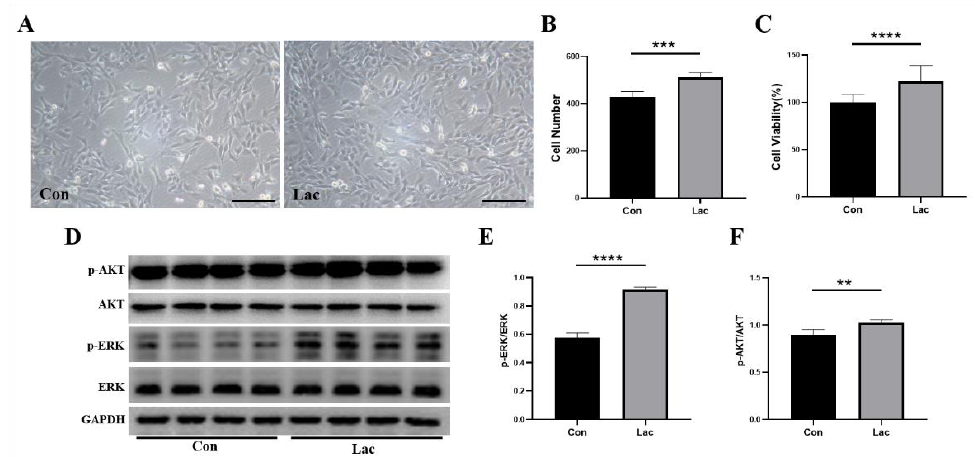
Figure 1. Lactate treatment promoted the proliferation of myoblasts. Cells were cultured for 24 h in either DMEM medium (Con) or DMEM medium supplemented with 5 mM lactate (Lac). ( A ) Representative morphological images of the cells. Scale bar: 200 µ m; ( B ) Cell number statistics in panel ( A ) ( n = 5); ( C ) Viabilities of lactate-treated cells relative to controls measured by the MTS assay ( n = 10); ( D – F ) Expressions of p-AKT (Ser473), AKT, p-ERK (Thr202/Tyr204) and ERK in the Lac and Con groups of cells ( n = 4). Results are presented as Mean ± SD. ** p < 0.01, *** p < 0.001, **** p < 0.0001 for the statistical analysis of Lac vs.